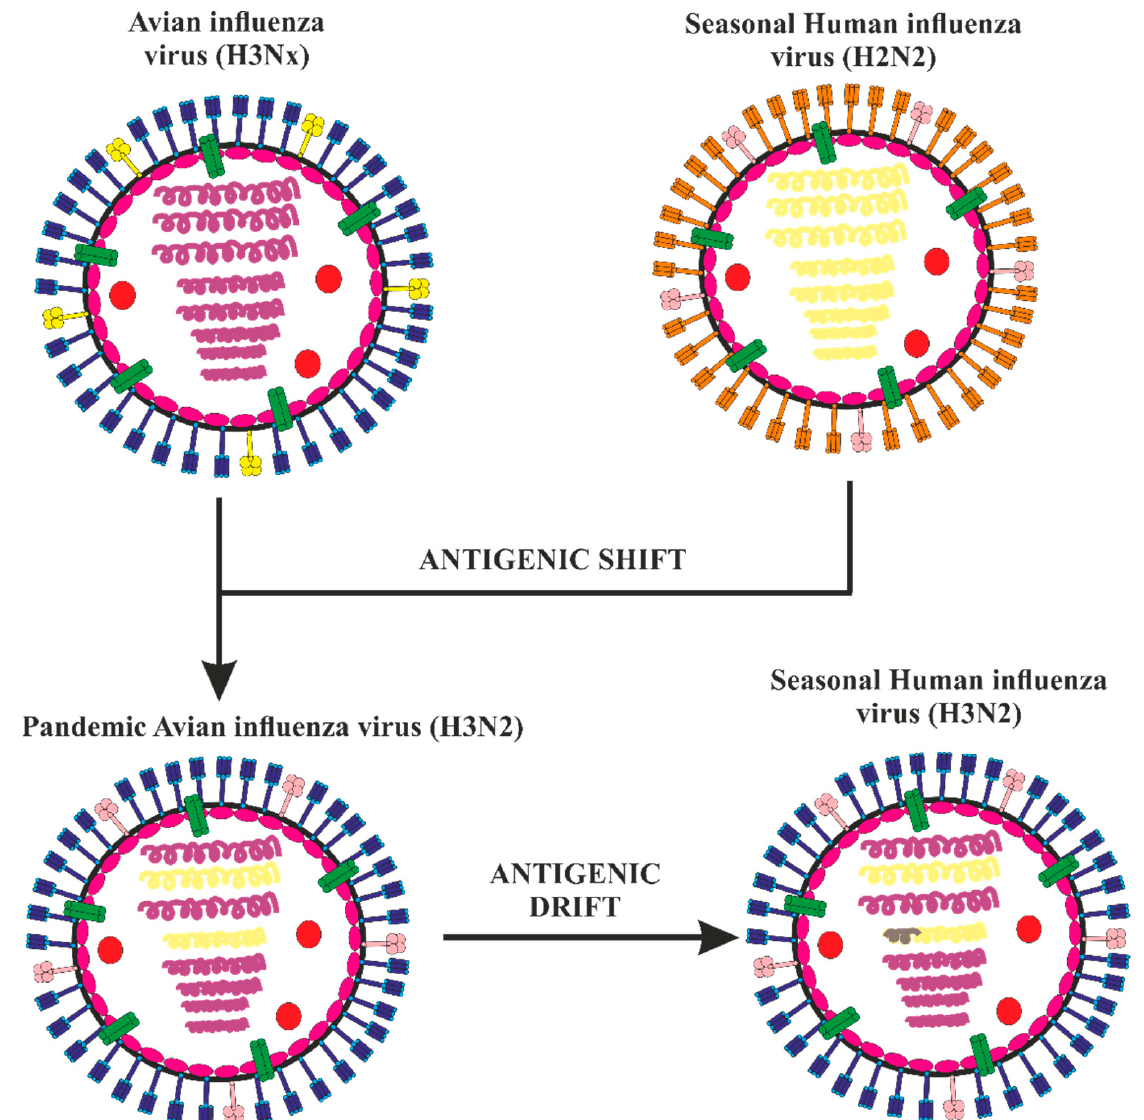
Figure 4. The seasonal human influenza virus and an avian influenza A H3Nx (where x = 1–9) virus co-infected each other in 1968. The RNA polymerase PB1 and hemagglutinin (HA) RNA segments of the pandemic human influenza A H3N2 virus were selected as a result of the reassortment of viral segments between A H2N2 viruses, with the other segments being taken from the human virus. As with all other human seasonal influenza viruses, once H3N2 had established itself in people, it started to drift. Although not as significantly as during shift, modest antigenic alterations in the HA protein caused by mutation were chosen to promote immune evasion during drift. Figure is adapted from Krammer, 2018 [108].